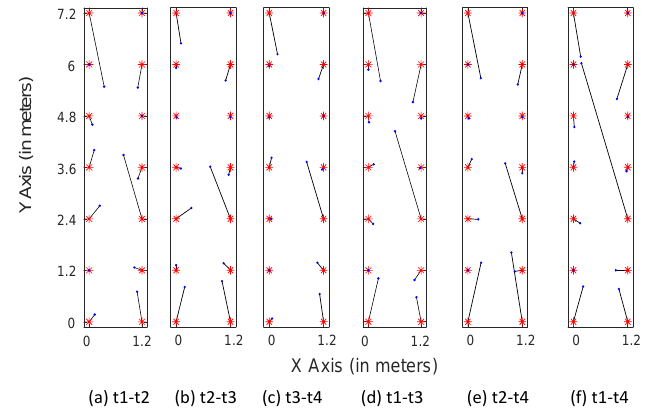
Figure 19. Localization results across different